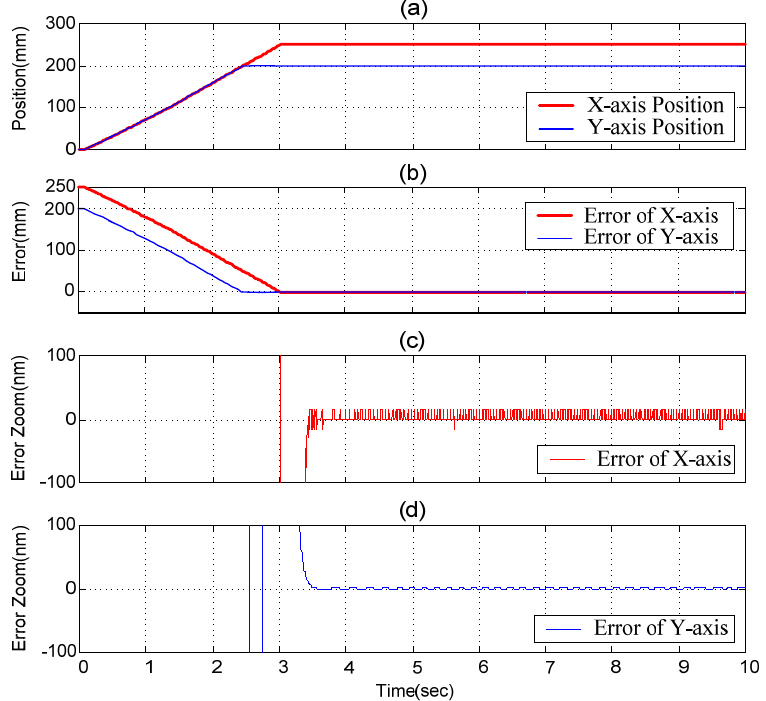
Figure 14. Control signals of the positioning control of XY dual-axial pneumatic-piezoelectric hybrid actuators by DSOFSMC with X-Y decoupling controller: strokes of (X,Y) = (250 mm, 200 mm), (a) equivalent control error e control signal of X-axis, (c) piezoelectric control signal of X-axis, (d) equivalent control , (e) pneumatic control signal of Y-axis, (f) piezoelectric control signal of error e xy